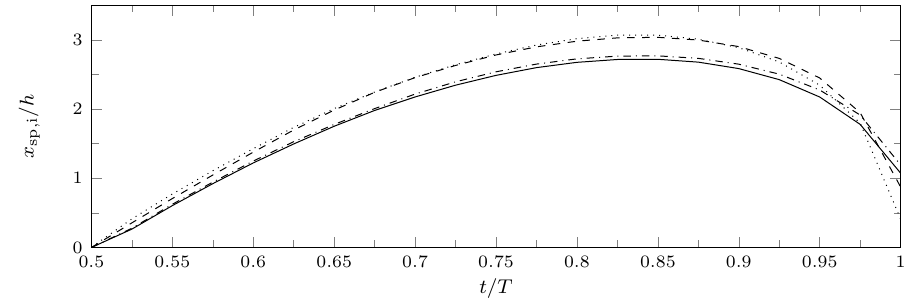
Figure 10. Saddle point position x sp,i , during the suction phase, for different slots: continuous and dotted lines refer to outer slots; dashed and dashdotted lines to inner